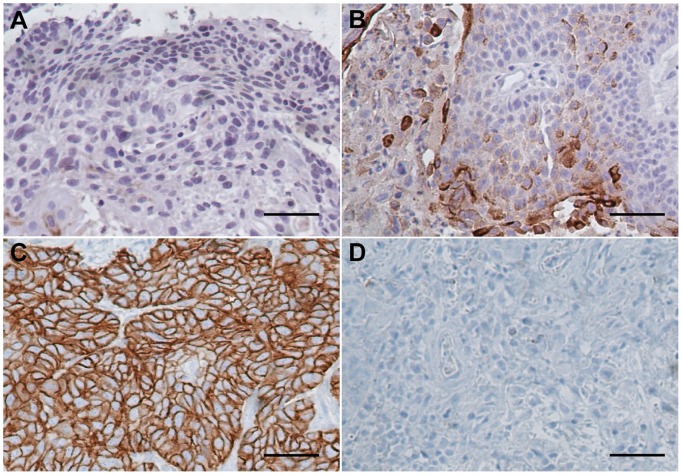
Representative immunohistochemical staining of STC2 in LSCC.Positive immunostaining was observed in the cytoplasm and membranes of tumor cells. (A) Negative expression of STC2 in adjacent non-cancerous epithelial tissues. (B) Low expression of STC2 in well-differentiated glottic LSCC. (C) High expression of STC2 in poorly differentiated supraglottic LSCC. (D) Staining with negative control (phosphate-buffered saline) in LSCC specimens. (magnification 200×, scale bar = 50 µm).